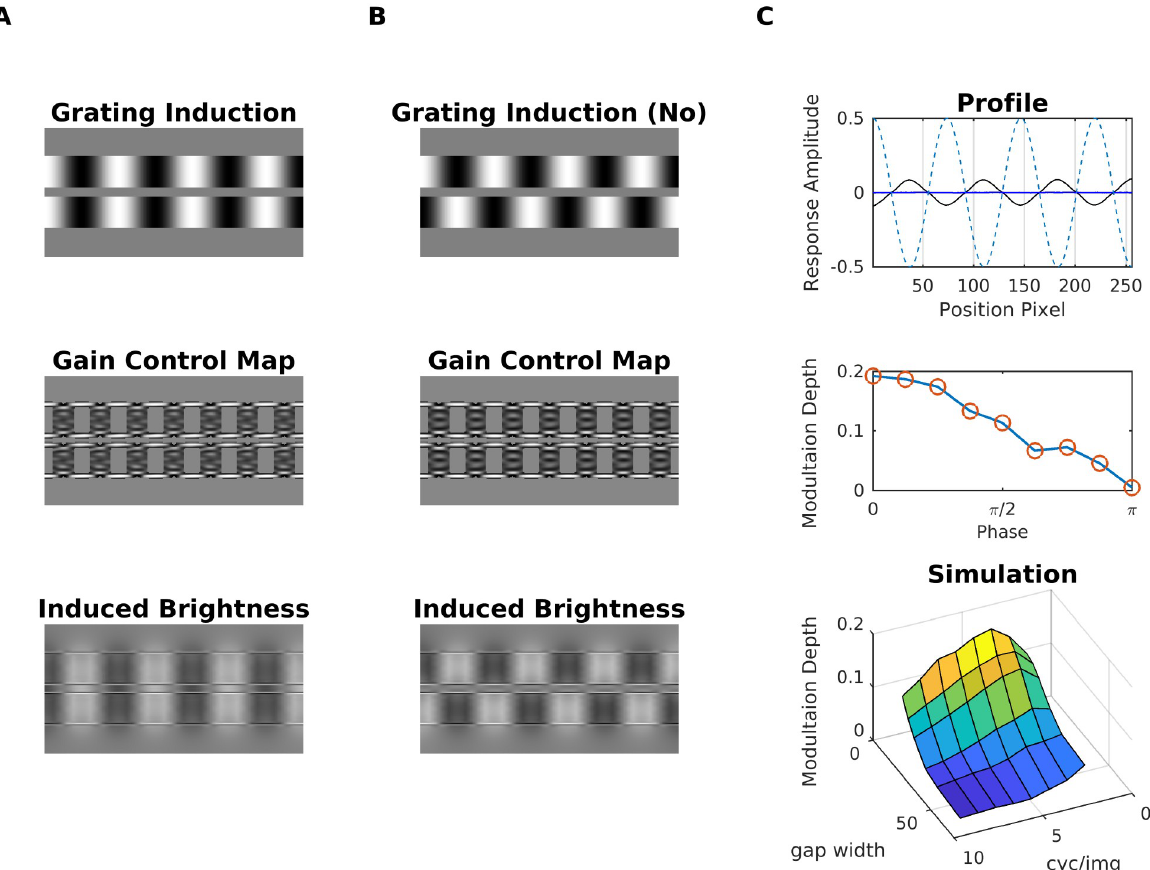
Fig 21. Model prediction for grating induction. (A) The Grating Induction refers to the illusory perception of a brightness modulation across the gap (=test field) between the inducer gratings. The brightness modulation is perceived in opposite phase to the inducer gratings. (B) When the inducer gratings stand in opposite phase to each other, then brightness modulation is considerably reduced. The corresponding gain control maps are shown in the middle row, and the last row shows the induced brightness, which consists of the difference map between estimated brightness and input luminance (i.e., brighter gray levels mean positive values, and darker gray levels mean negative values). (C) Top: Profile plot of brightness estimation for display A (black line) and display B (blue line). The dashed blue line shows the luminance profile of the inducer grating A. Middle, modulation depth as a function of the phase difference between the two inducer gratings. Bottom: Surface plot that shows how modulation depth depends on test field width and spatial frequency of the inducer grating.